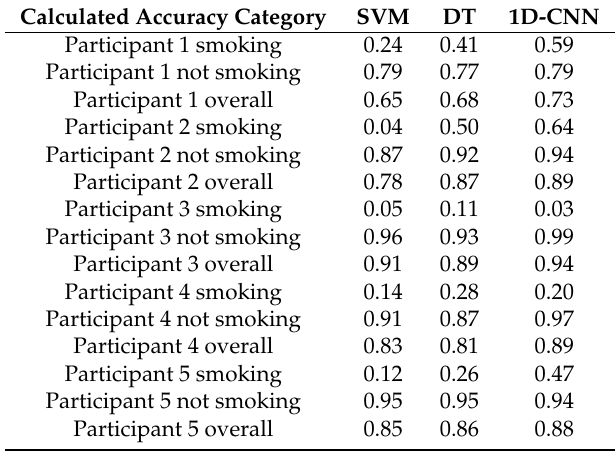
Table 4. The average accuracy based on all 6 featuers accelerometer and GPS